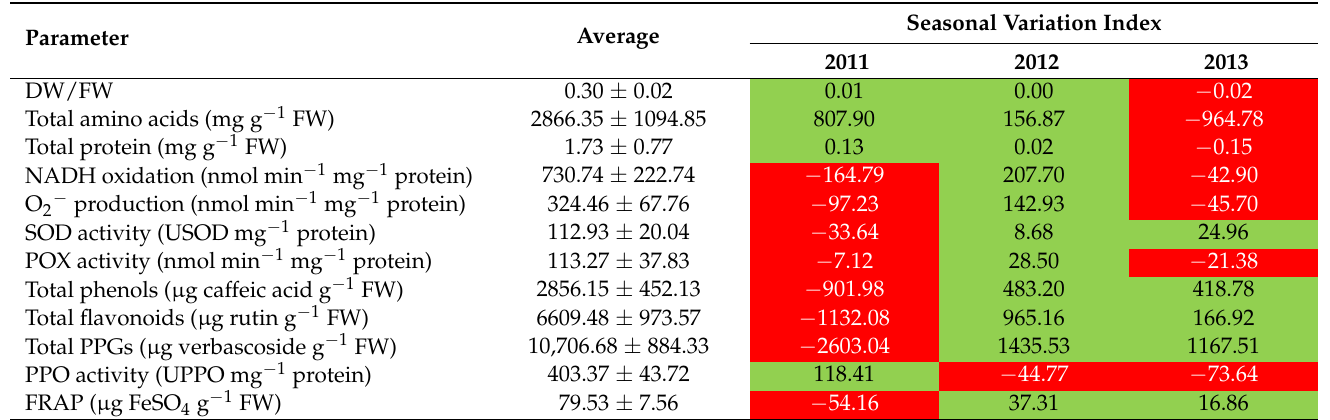
Table 2. Average of the three years and seasonal variation index corresponding to each year (derived from Table S3).